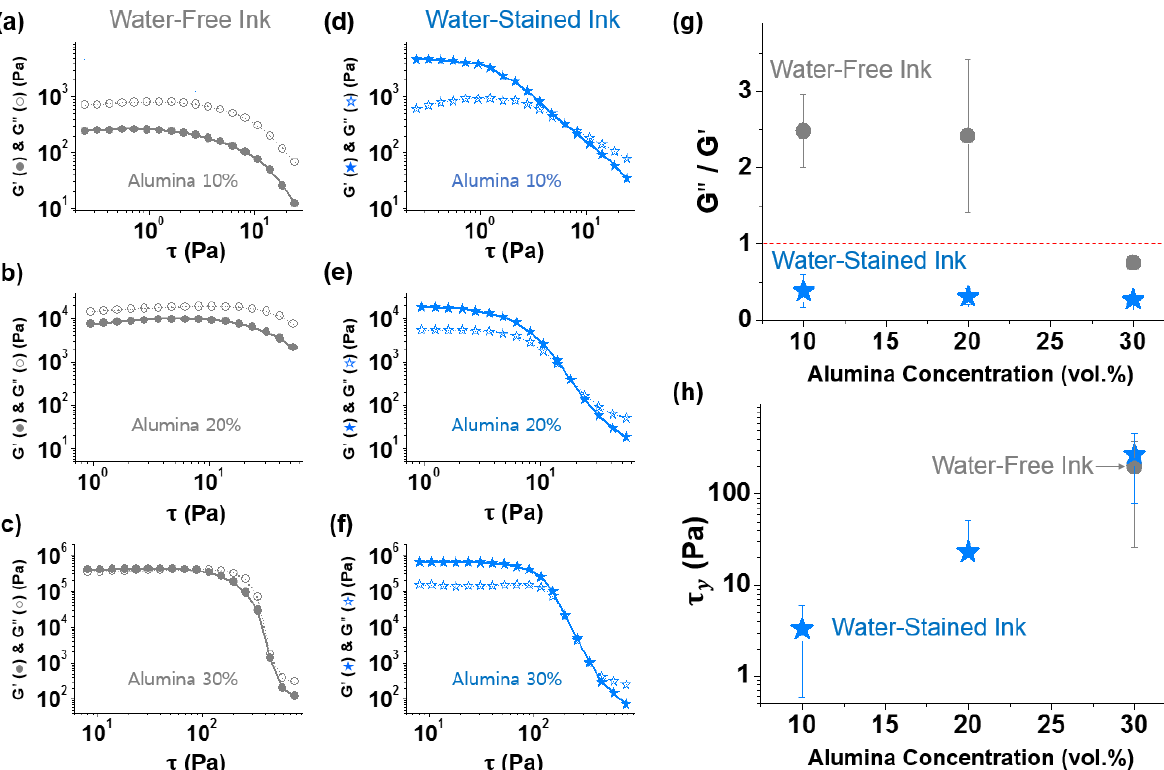
Figure 2. Representative elastic ( G′ , filled) and viscous ( G″ , empty) moduli of water-free epoxy – alumina inks (gray circles) with alumina concentration of ( a ) 10, ( b ) 20, and ( c ) 30 vol.% and those of water-stained inks (blue stars) with alumina concentration of ( d ) 10, ( e ) 20, and ( f ) 30 vol.% and a fixed water concentration of 3 vol.%, as functions of applied shear stress ( τ ) in oscillatory measurements (at 1 Hz) using a stress ramp. ( g ) Initial G″/G′ and ( h ) yield stress ( τ y ) values for water-free (gray circles) and water-stained (blue stars) inks. Data in ( g ) and ( h ) are averaged values for the results from at least three independent measurements, which are described as functions of alumina concentrations.